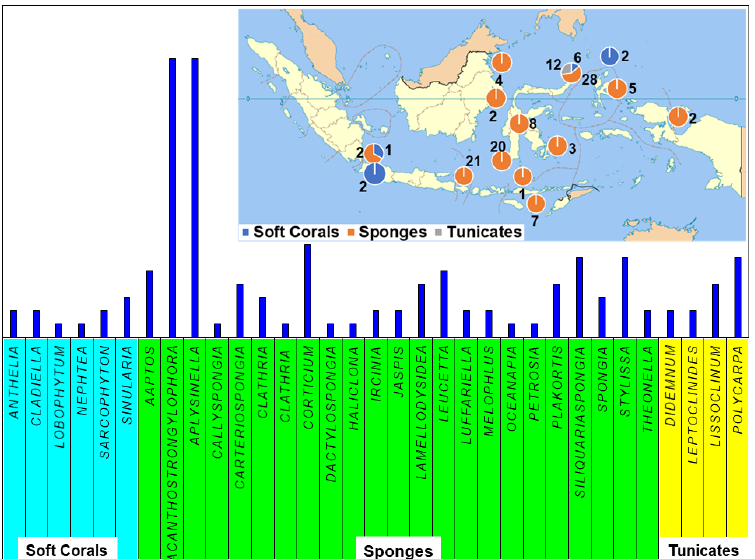
Figure 13. The distribution of sample origin and the division of compound class by genus. A terpenoid compound, 3,4-epoxy-nephtenol ( 127 ), was isolated from the soft coral Nephthea sp. found in Seribu Islands, DKI Jakarta [58]. Compound 127 showed weak inhibitory growth against three human tumour cell lines, i.e., human glioblastoma SF268, human breast MCF-7, and human non-small cell lung H460 cancer cells [58].